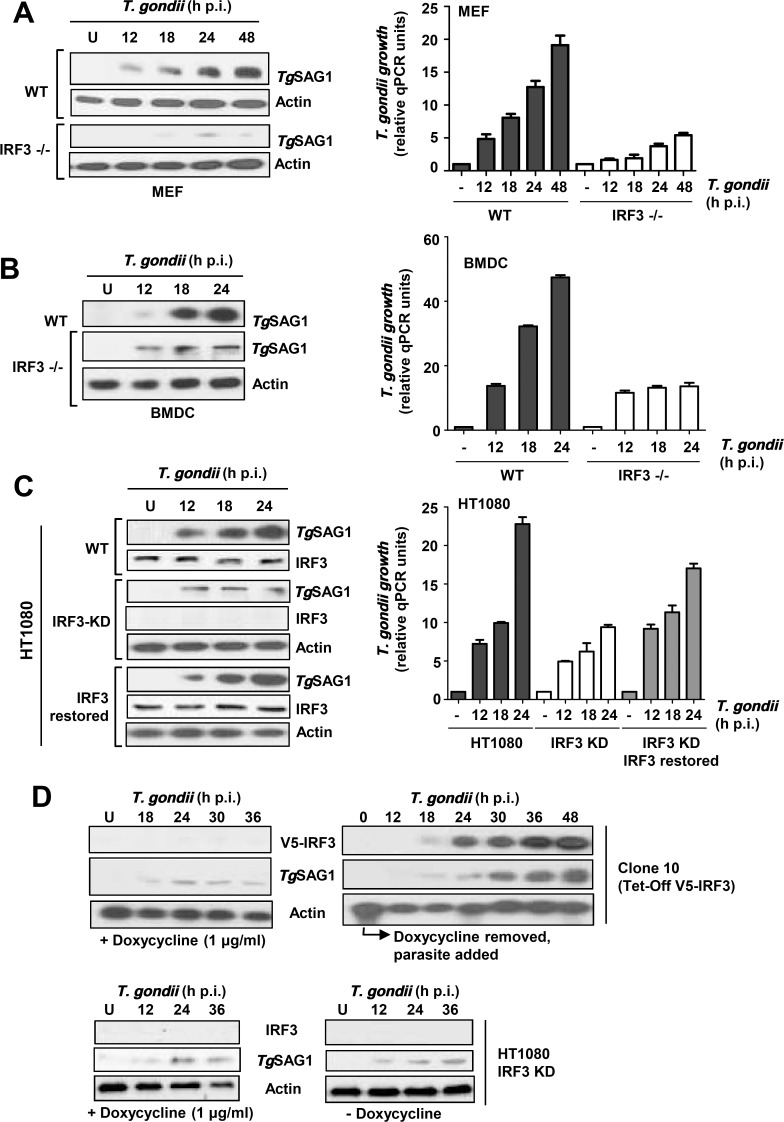

T. gondii replication is stimulated by IRF3.
A/B/C, Three types of cells (MEF: mouse embryonic fibroblasts, DC: mouse dendritic cells, HT1080: human fibroblasts) were infected with T. gondii RH (a virulent type I strain). Total infected cell proteins at the indicated times post-infection were analyzed by immunoblotting to detect T. gondii SAG1 protein. U = uninfected cell control. The IRF3-deficient (KO = knockout; KD = knockdown with stably expressed shRNA) cells were compared with the corresponding wild type (WT), or with IRF3- restored, cells as noted. Parasite growth was also quantified by qPCR of genomic DNA using the invariant ITS-1 primers and normalized against GAPDH. D, Use of Tet (Dox)-off IRF3 expression system (Clone 10 cells) shows parasitic growth kinetics in response to IRF3. Immunoblot of the V5-tagged Tet-regulated recombinant IRF3 (top panels), T. gondii SAG1 (middle panels), and control actin (bottom panels) are shown. Left: Poor parasite growth in IRF3-repressed cells. Right: Growth kinetics of the parasite in the Clone 10 cells, in which IRF3 was induced by the withdrawal of Dox. In all panels, actin serves as the loading control. V5-IRF3 was detected by anti-V5 antibody.